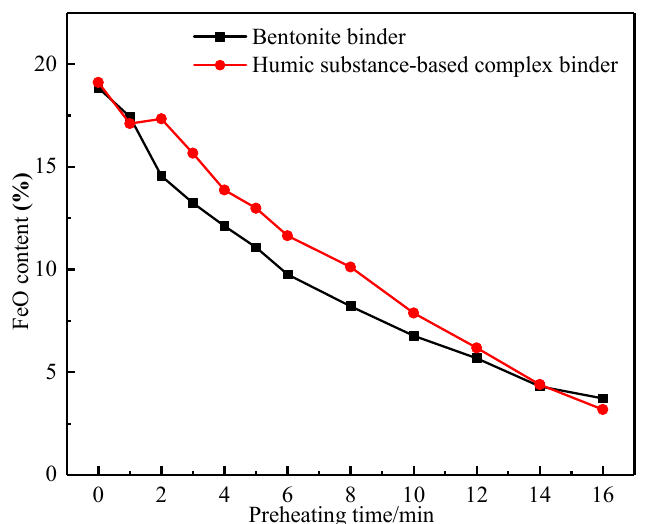
Figure 10. Effects of preheating time on FeO content.